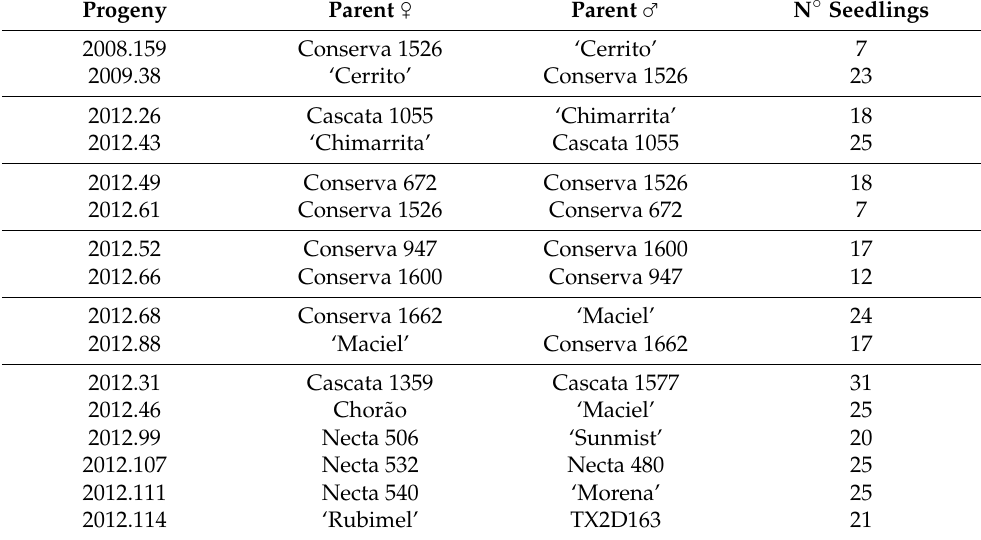
Table 1. Progeny identification, parents, and number of seedlings of each progeny, in the Peach Breeding Program at Embrapa Clima Temperado, Pelotas, Rio Grande do Sul, Brazil.